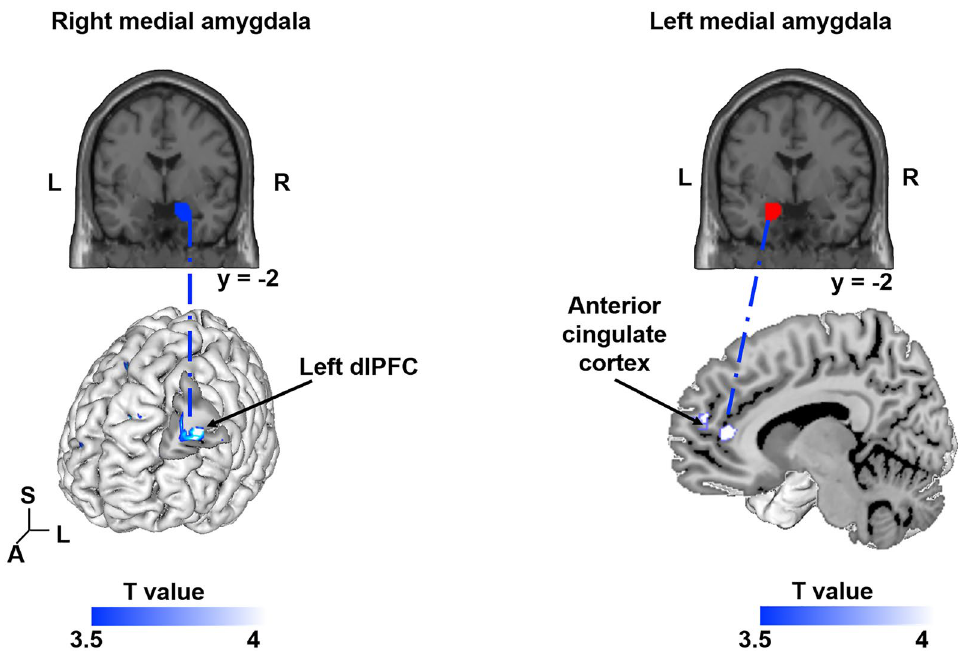
Figure 4. SERT availability in the dorsal raphe nucleus modulates the strength of the coupling between the medial amygdala and dorsolateral prefrontal/ACC when viewing negative emotional faces. A negative correlation was observed between the SERT level in the DRN and BOLD response in the comparison (Fear Face and Angry Face) > Fixation Cross. The connectivity between the right medial amygdala and the left dlPFC (x, y, z = − 40, 24, 26; t = 4.74) decreased as the SERT availability level in the DRN increased. (p < 0.05, family- wise error [FWE] small volume corrected in a sphere of radius of 10 mm centered on a meta-analysis peak x, y, z = − 44, 22, 24). In addition, results show that the connectivity between the left medial amygdala and the ACC (x, y, z = 8, 40, 6; t = 4.38) decreased as the SERT availability level in the DRN increased (p < 0.05, family-wise error [FWE] small volume corrected in a sphere of radius 10 mm centered on the meta-analysis peak x, y, z = 0, 40,